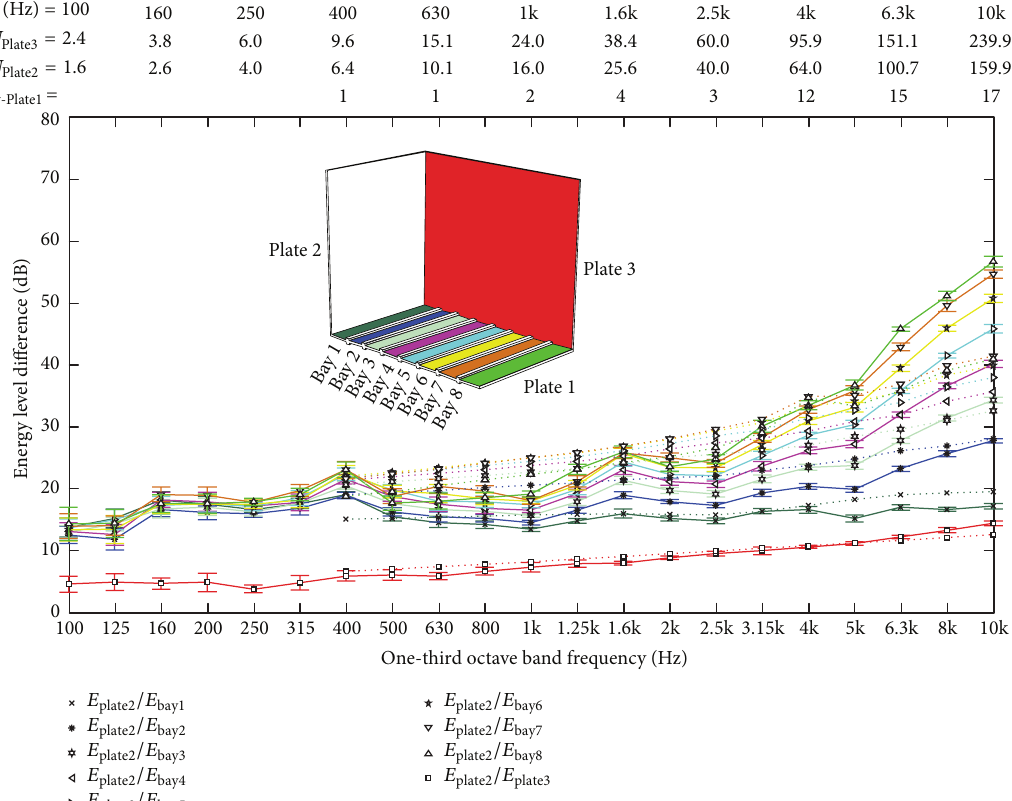
Figure 13: Three coupled plates. Excitation: Plate 2. Energy level differences between the isotropic plate (Plate 2) and each of the bays that form the other periodic ribbed plate (Plate 1) as well as the other isotropic plate (Plate 3). Comparison between FEM and ASEA (FEM data are shown using markers with continuous lines; ASEA data are shown using markers with dotted